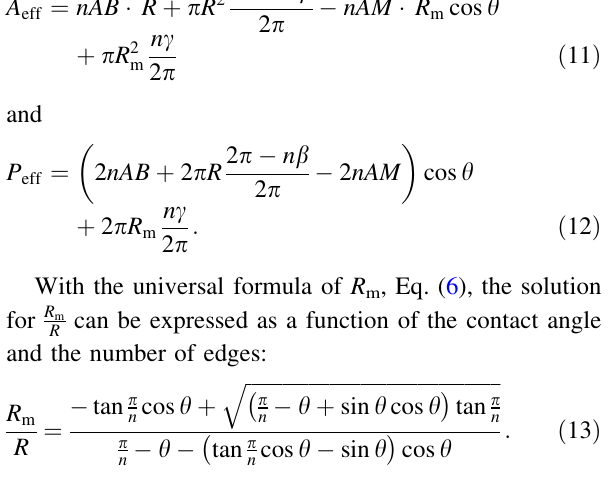
The effect of the contact angle on the normalized threshold radius for different equilateral polygonal tubes with various numbers of edges is plotted in Fig. 5. These equilateral polygons are a regular triangle, quadrilateral, pentagon, hexagon, octagon, and decagon, whose vertices are 60 (cid:3) , 90 (cid:3) , 108 (cid:3) , 120 (cid:3) , 135 (cid:3) , and 144 (cid:3) , respectively. The curves in Fig. 5 have trends similar to the curves in Fig. 4: R m increases with an increasing contact angle, and the R Fig. 4 Normalized threshold radius, R m , as a function of the contact R angle, h , and the corner angle, a minimum normalized threshold radius value of the graph